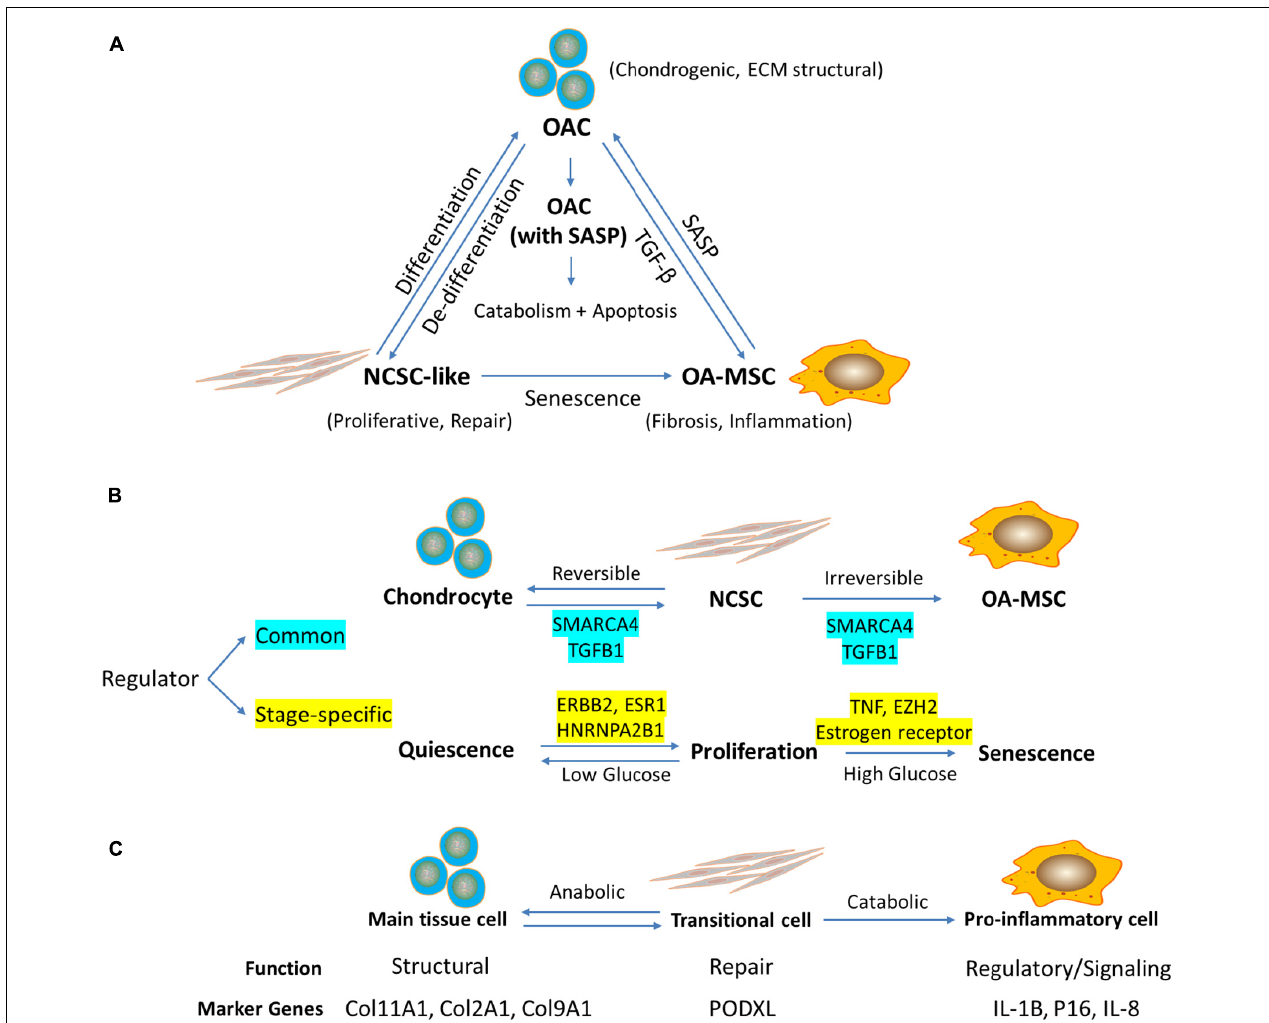
FIGURE 7 | RNA sequencing analysis indicates the relationship among chondrocytes, mesenchymal stromal cells (MSC), and senescent MSC in human articular cartilage during aging. (A) Working hypothesis of the relationship among OAC, NCSC-like cells, and OA-MSC in aged human OA cartilage. Cartilage defect due to aging, stress, or injury induces proliferation and dedifferentiation of OAC, which results in NCSC-like cells for tissue repair. Repeated activation of NCSC-like cell replication in aged cartilage induces replicative senescence, which results in senescent OA-MSC. OA-MSC synthesizes pro-inflammatory SASP including IL-1b, IL-6, CXCL1, 5, 6, and 8. Upon binding its receptors on OAC, SASP activates cytokine-induced catabolism and apoptosis of OAC, thereby contributing to joint degeneration and OA pathogenesis. (B) Regulators of Senescence Associated Cell Transition (SACT) during cartilage aging. RNAseq analysis identified common and stage-specific regulators of cell transitions during chondrocyte aging process. The working hypothesis is that SACT comprises two cell transitions during aging. The first transition converts quiescent normal adult articular chondrocytes into proliferative and de-differentiated NCSC. The second transition converts proliferative NCSC into senescent and pro-inflammatory OA-MSC. The common regulators governing both transitions include SMARCA4 and TGFB1. The stage-specific regulators for the first transition include ERBB2, ESR1, and HNRNPA2B1. The specific regulators for the second transition include TNF, EZH2, and estrogen receptor. While the transition of chondrocytes to NCSC or vice versa is reversible, the transition of NCSC to OA-MSC may be irreversible. While high glucose drives MSC senescence and inflammation, low glucose may maintain the NCSC/chondrocyte balance for tissue repair (Jiang et al., 2016). (C) Proposed function and marker genes for OAC, NCSC, and OA-MSC in human articular cartilage. The working hypothesis is that chondrocytes serve a structural function as the main tissue resident cells in cartilage; NCSC serve as a transitional cell for tissue repair and wound healing in response to stress, injury, or aging; and OA-MSC serve as a regulatory, signaling cell during injury, and aging process. The marker genes for chondrocytes include chondrogenic ECM COL11A1 , COL2A1 , and COL9A1 ; NCSC marker gene includes MSC marker PODXL ; and OA-MSC marker genes include cell senescence and SASP markers IL1B , P16 , and IL8